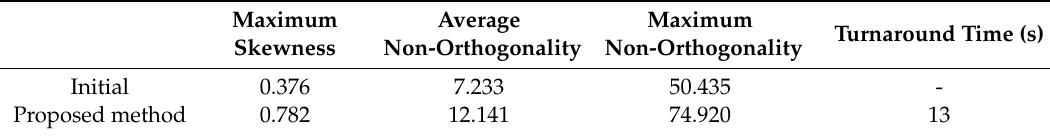
Table 3. Quality of the deformed mesh using the proposed method.